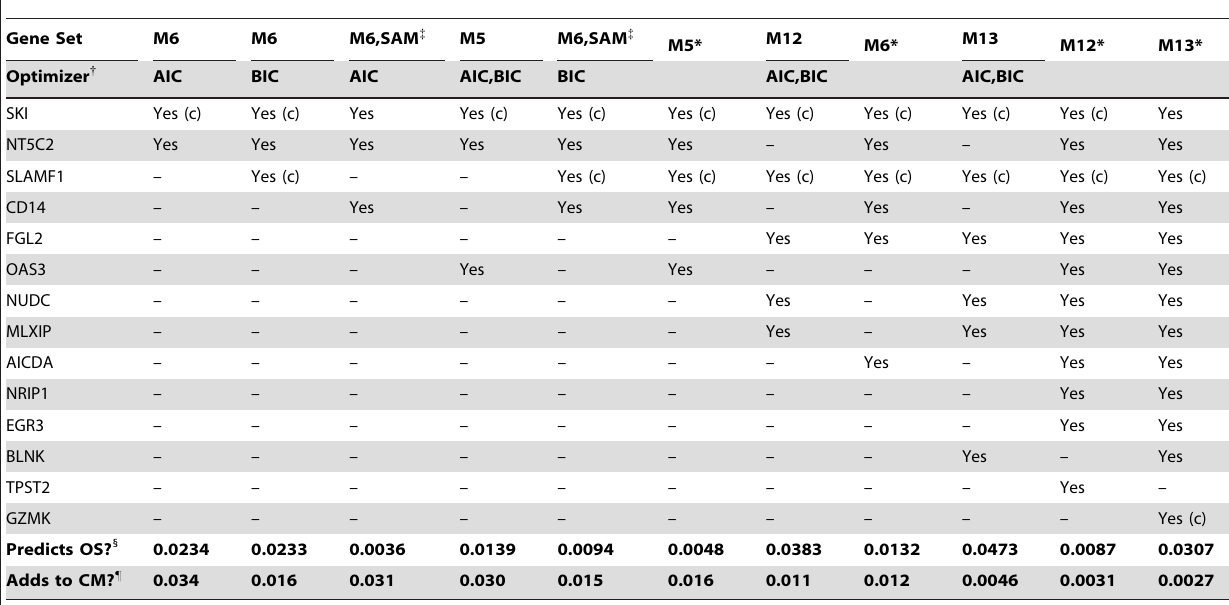
Table 3. Genes retained in multivariate models to predict time from diagnosis to treatment in the training dataset.